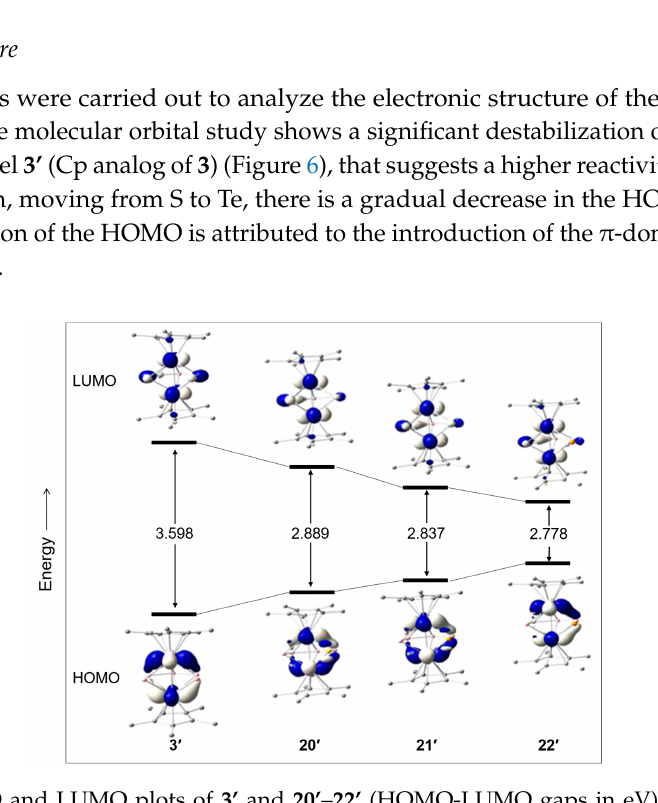
Table 3. Skeletal electron pair count (sep), selected structural parameters, and 11 B chemical shifts of 20 – 22.